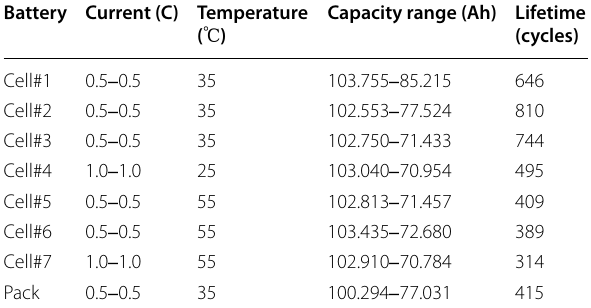
Table 1 Specific information for the experimental data Battery Current (C) Temperature ( ℃ )